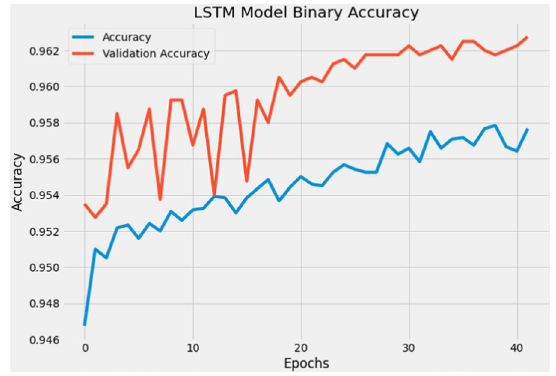
Fig. 11 Training and validation accuracy of ANN